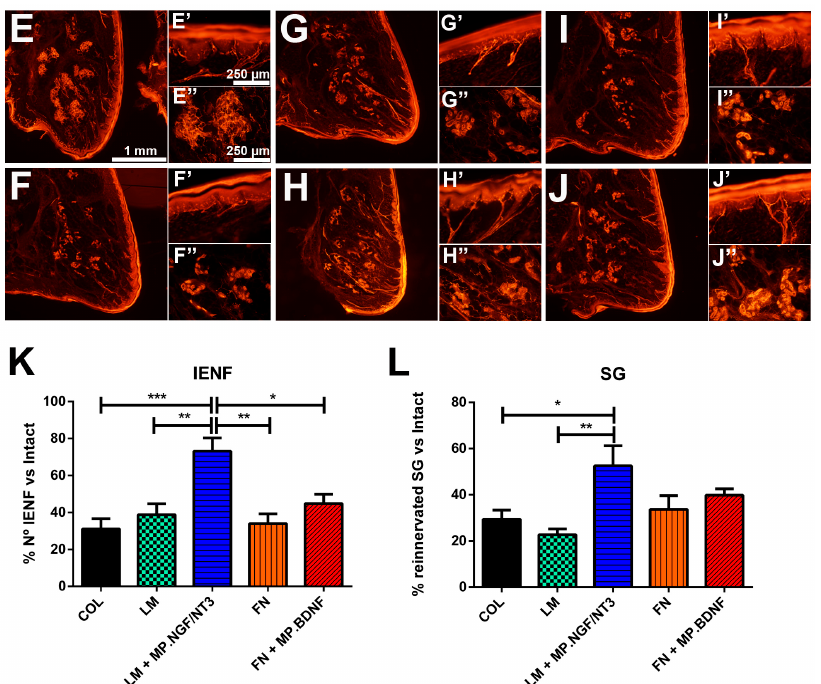
Figure 4. FN + MP.BDNF and LM + MP.NGF/NT3 enhance motor and sensory functional recovery, respectively. ( A , B ) Mean amplitude of the CMAP in TA ( A ) and PL ( B ) muscles during follow-up. ** p < 0.01 and *** p < 0.001 FN + MP.BDNF vs. all other groups referenced by the color of the star. ( C )